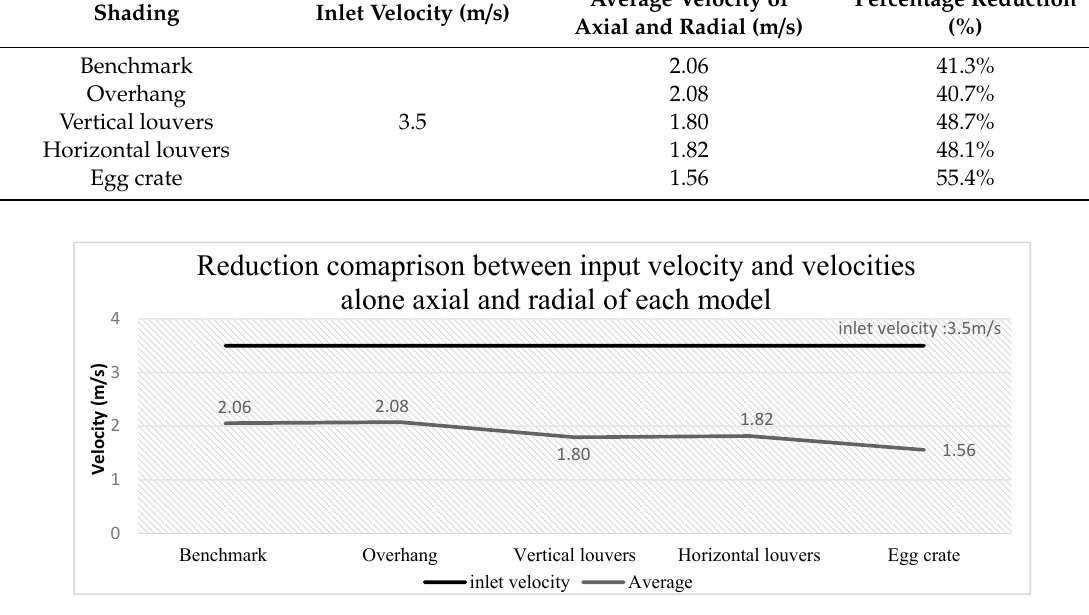
Figure 12. Comparison of the inlet velcoity and overall average velocity.